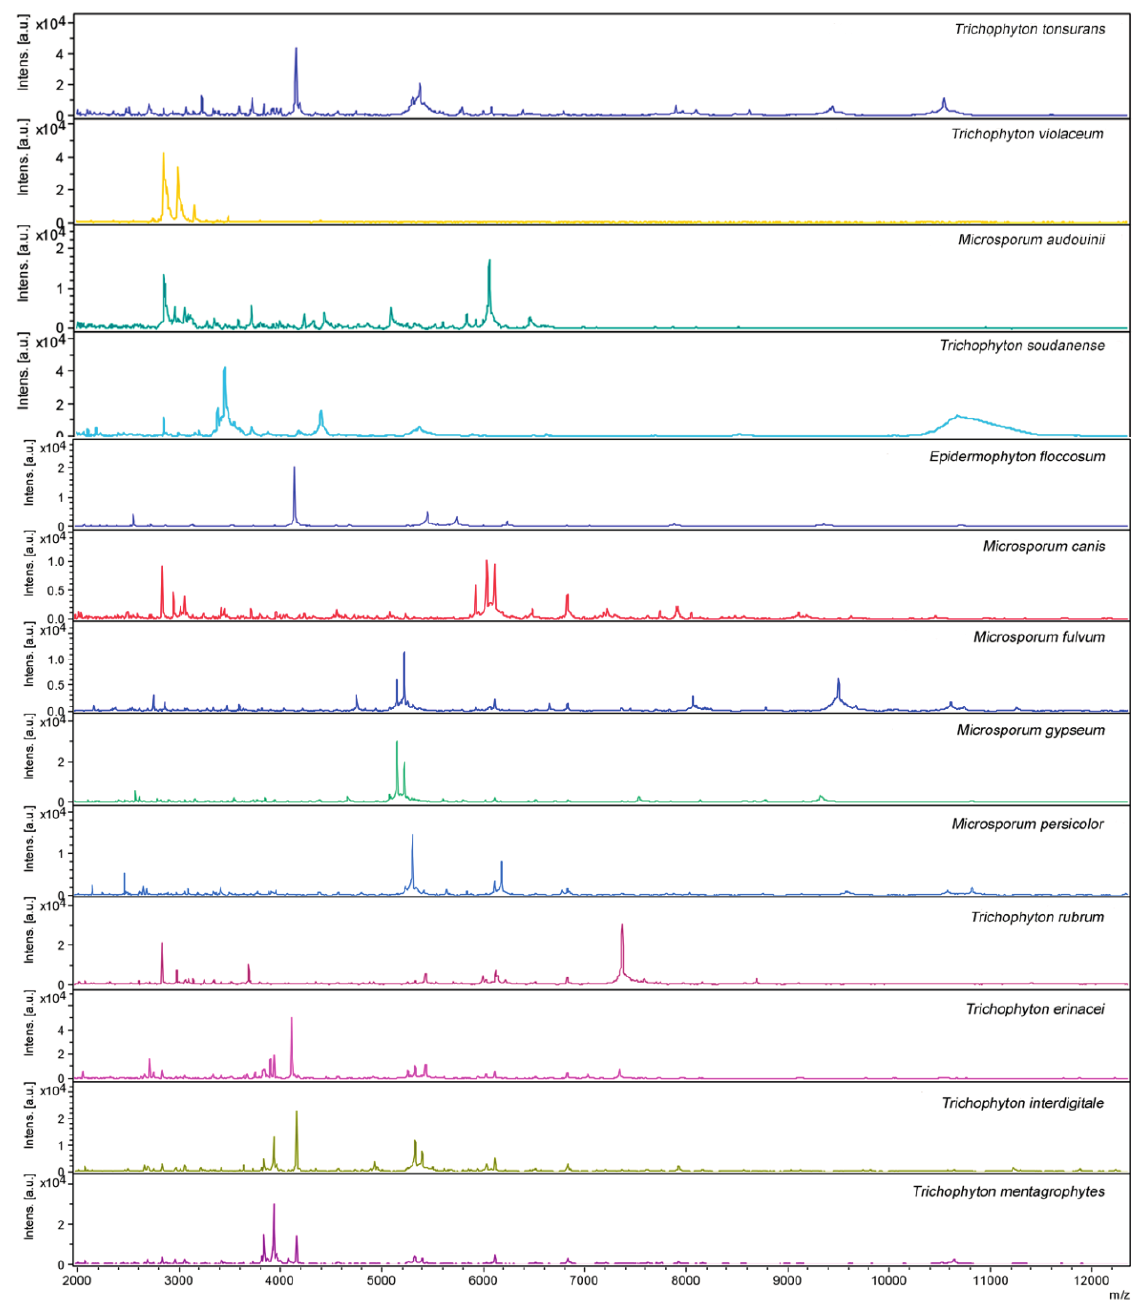
Figure 1. Spectra obtained by MALDI-TOF MS analysis of the 13 species of dermatophytes supplemented in the Bruker Daltonics